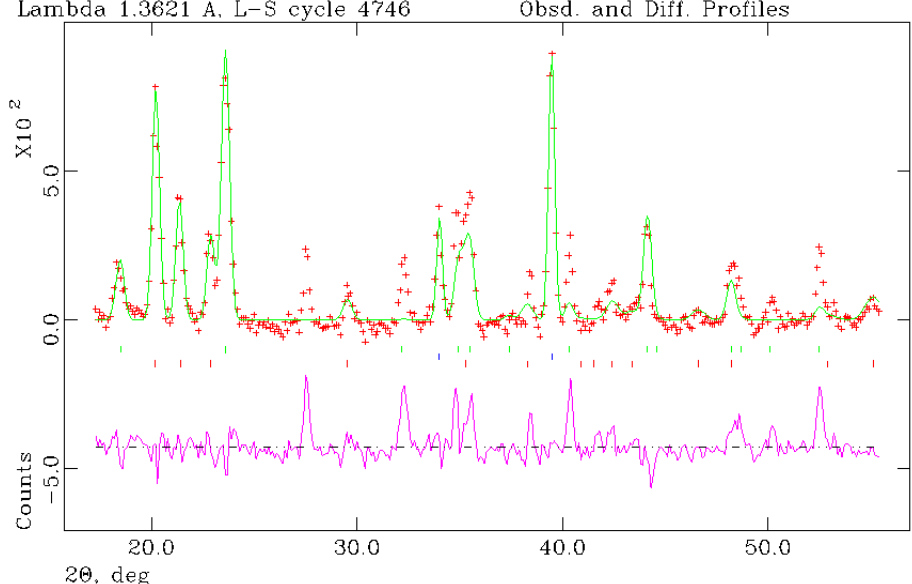
Figure 1. Example of neutron diffraction patterns recorded with the D 2 O/MGQS mixture at T = 250 K; λ = 0.1362 nm; crosses—the experimental data points; full line—the Rietveld fit. Diffraction maxima corresponding to α -quartz (sand), aluminum (container) and hexagonal Ih D 2 O are indicated below the profile by the green, blue and red lines, respectively. At the bottom, the pink curve shows the residual difference between the observed and fit intensity.